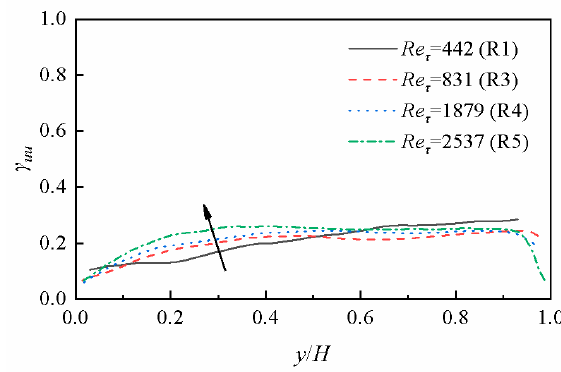
Figure 8. Streamwise kinetic energy fraction contributed by VLSMs using 20 H as a separation scale.